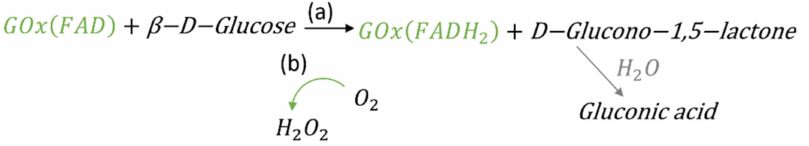
Scheme 1. Representation of the enzymatic oxidation of glucose by the GOx enzyme in the presence of O 2 , evidencing the oxidized and reduced form of the cofactor